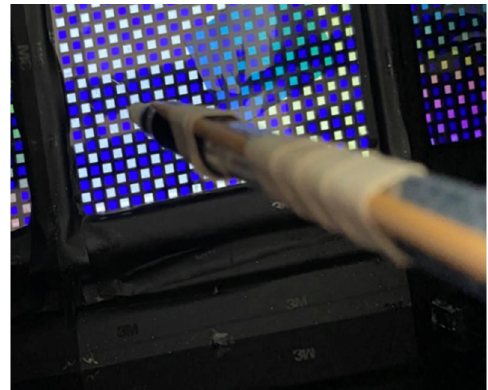
Figure 11. Experimental method diagram.